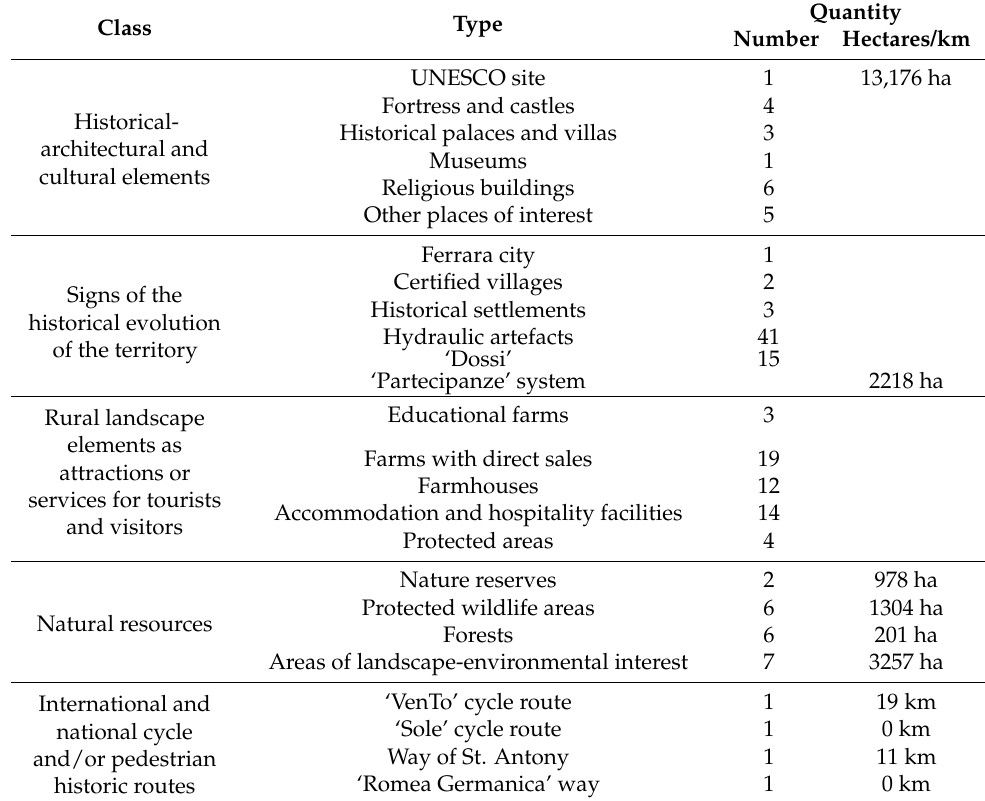
Table 1. Elements of interest in the study